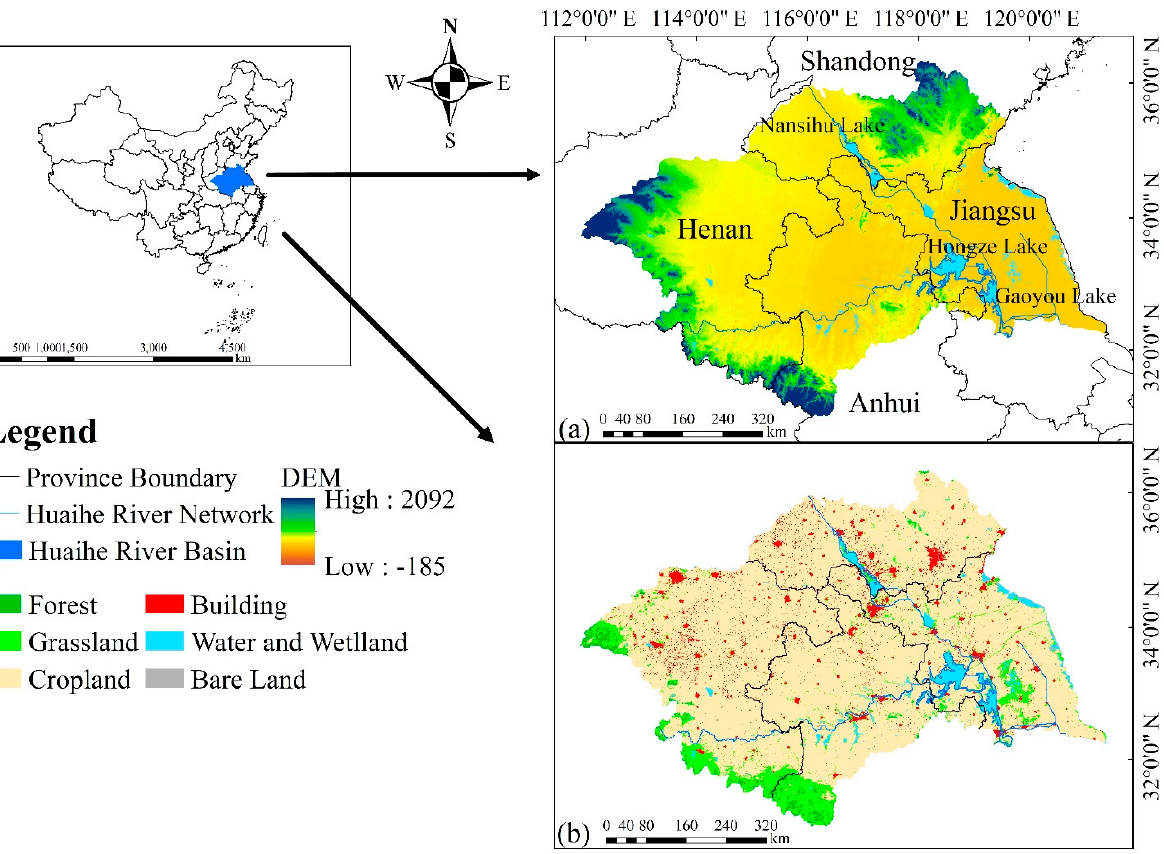
Figure 1. Location of the HRB. ( a ) Digital elevation model-derived map (from ASTER GDEM data) of the HRB showing Jiangsu, Anhui, Shandong, and Henan provinces and three main lakes (Nansihu Lake, Hongze Lake, and Gaoyou Lake). ( b ) Land use map (from MOD12Q1 data) of the HRB in 2001.